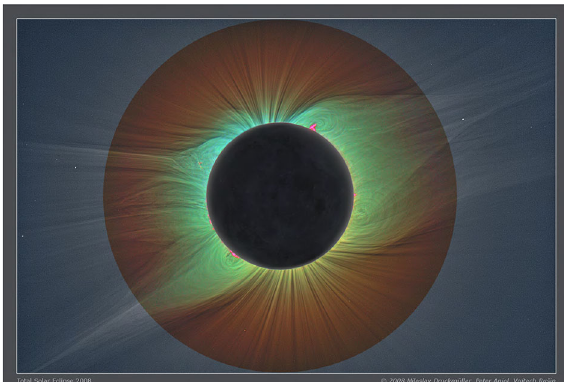
Fig. 1 Prominences in true color during 2008 total solar eclipse. Image reproduced with permission from http://www.zam.fme.vutbr.cz/~druck/eclipse/, copyright by Miloslav Druckmüller, Peter Aniol,